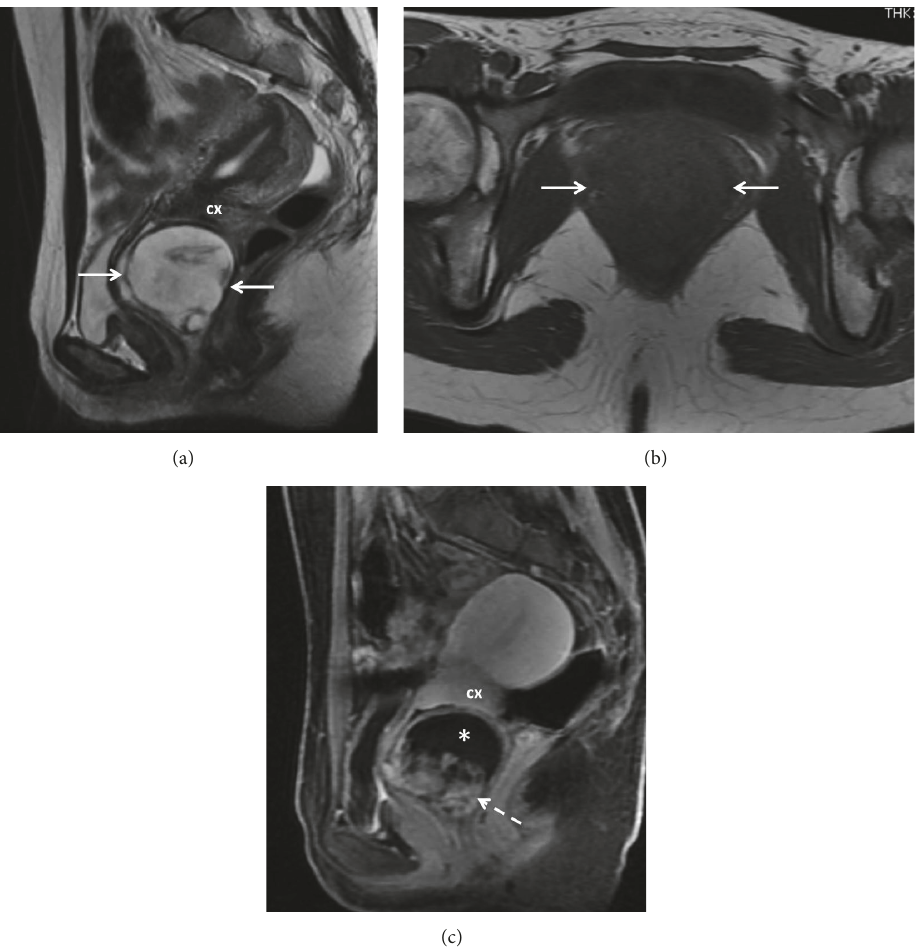
Figure 3: (a) Sagittal T2 weighted image shows a predominantly hyperintense mass (arrows) with small central areas of hypointensity. (b) On T1 weighted axial image the mass is homogeneously hypointense (arrows). (c) Sagittal contrast enhanced image demonstrates heterogeneous hyperenhancement inferiorly (dashed arrow) and absent enhancement superiorly ( ∗ ). Cervix: